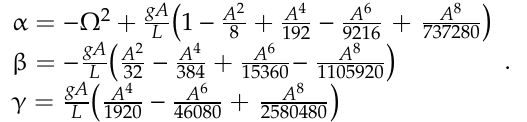
Figure 20. Comparison between the approximate solution (50) and numerical integration results for